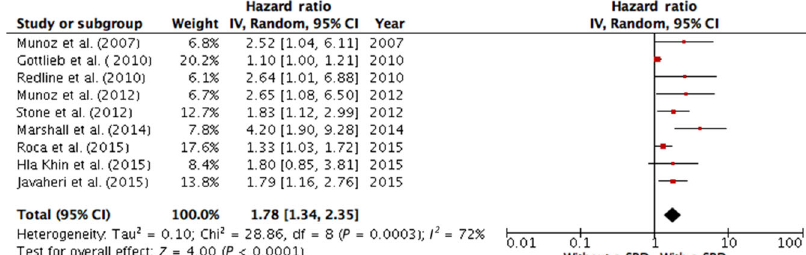
Fig. 2 Meta-analysis of association between sleep-disordered breathing and risk of cardiovascular disease (hazard ratios) in an unselected general population. Munoz et al. (2007) AHI cut-off 30, outcome — ischemic stroke; Gottlieb et al. (2010) AHI cut-off 15, outcome — coronary heart disease; Redline et al. (2010) AHI cut-off 15, outcome — incident stroke; Munoz et al. (2012) CAI cut-off 1, outcome — ischemic stroke; Stone et al. (2012) AHI cut-off 5, outcome — incident stroke; Marshall et al. (2014) AHI cut-off 15, outcome — all-cause mortality; Roca et al. (2015): AHI cut-off 15, outcome — all-cause mortality; Hla Khin et al. (2015) AHI cut-off 15, outcome — coronary heart disease and heart failure; Javaheri et al. (2015) CAI cut-off 5, outcome — incident heart failure. AHI apnea-hypopnea index, CAI central apnea index, CI con fi dence interval, IV inverse variance, SDB sleep-disordered breathing.